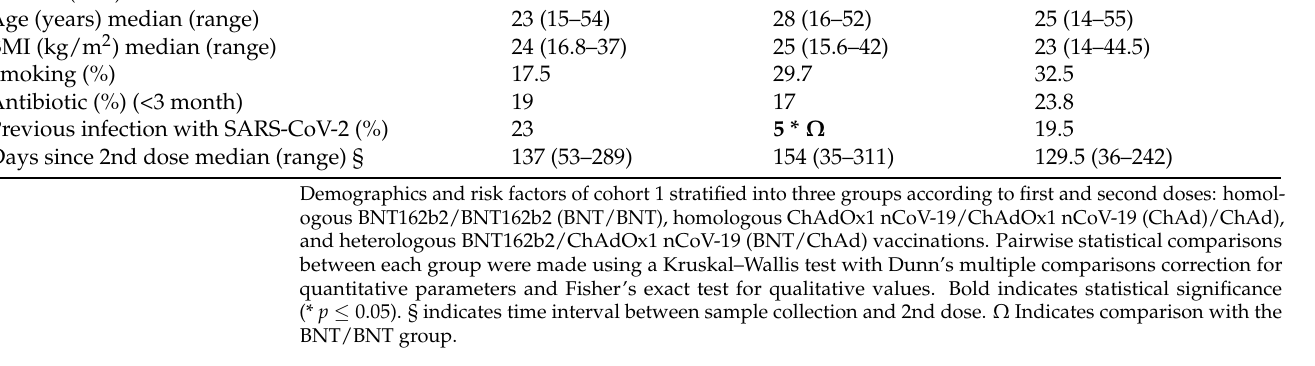
Table 2. Demographics of Cohort 2 Study